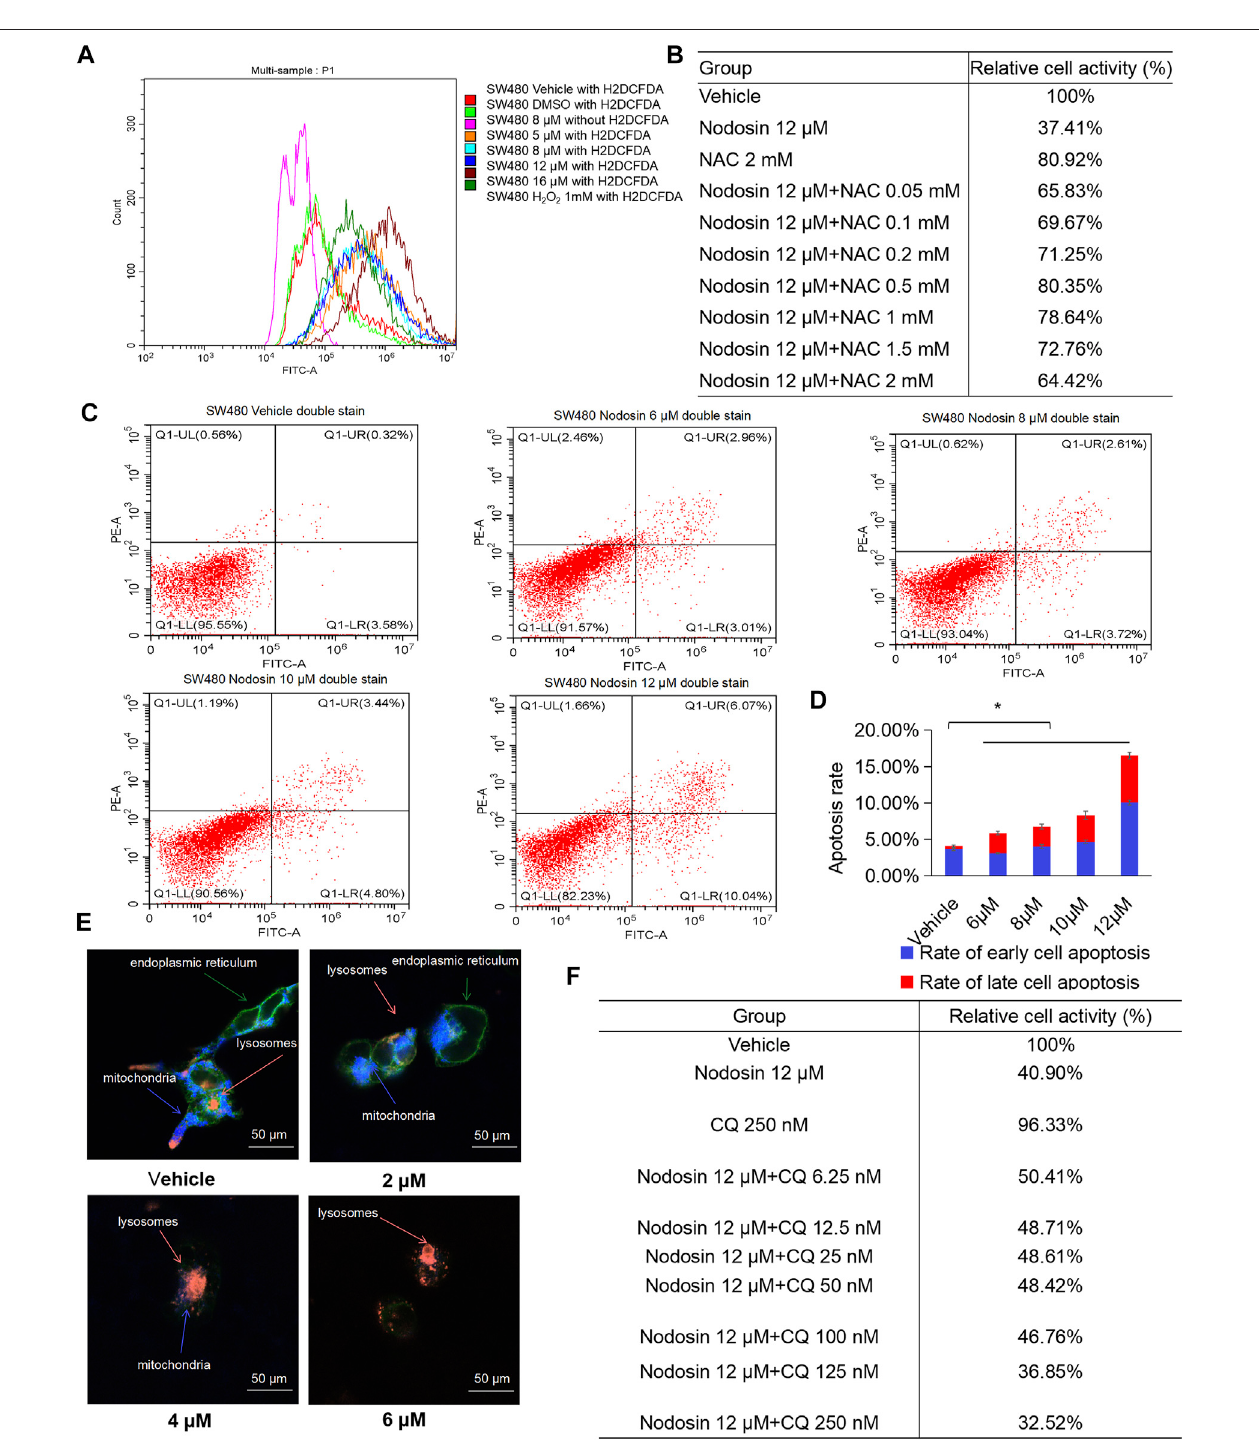
FIGURE 4 | Nodosin triggered cell death in CRC in a manner of oxidative stress, apoptosis and autophagy. (A) Intracellular ROS changes in SW480 caused by nodosin were determined by H 2 DCFDA, red indicated the blank control (no ROS probe), light green indicated the solvent control (DMSO treatment, including the ROS probe), purple indicated the negative control (8 μ M nodosin treatment, but with no ROS probe available), orange indicated the 5 μ M nodosin treated and containing the ROS probe, light blue indicated the 8 μ M nodosin treated and containing the ROS probe, dark blue indicated the 12 μ M nodosin treated and containing the ROS probe, brown indicated the 16 μ M nodosin treated and containing the ROS probe, dark green indicated a positive control (treated with 1 mM H 2 O 2 ). (B) SW480 cells were pretreated with ROS inhibitor NAC for 1 h and treated with nodosin for 48 h. The relative viability of cells was detected by CCK-8 kit. (C) Flow cytometry was